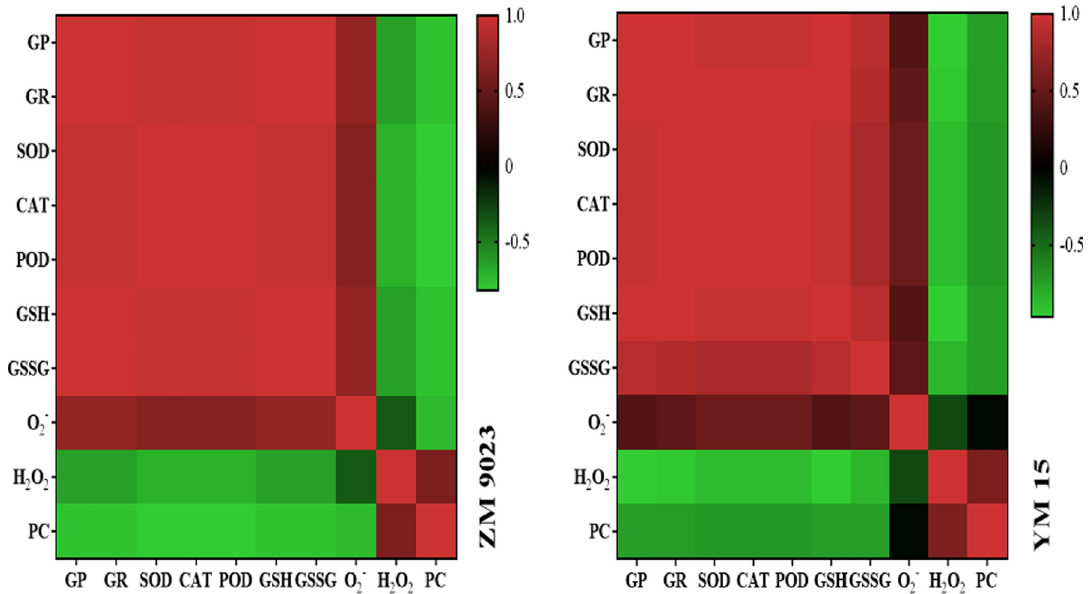
Fig 6. Heat maps of the correlation between seed vigor and carbonyl protein content, reactive oxygen content, non-enzymatic antioxidant contents and antioxidant enzyme activities of wheat seeds. GR: Germination rate; GP: Germination potential; SOD: Superoxide dismutase; CAT: Catalase; POD: Peroxidase; GSH: Reduced glutathione; GSSG: Oxidized glutathione; O 2 − : Superoxide anion; H 2 O 2 : Hydrogen peroxide; PC: Protein carbonyl.